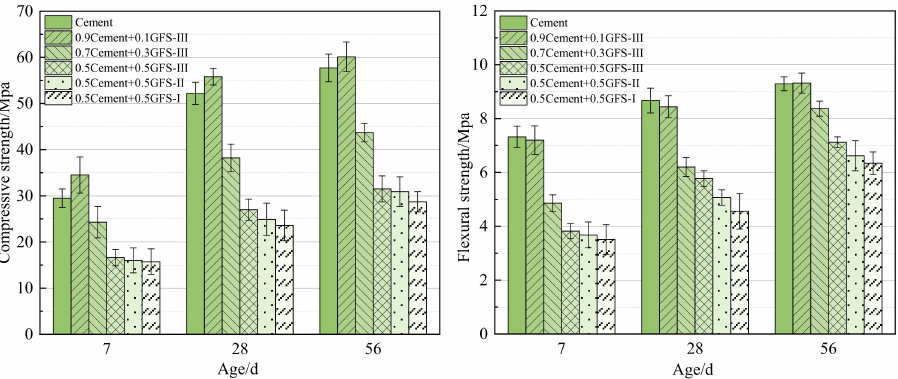
Figure 16. Compressive and flexural strength properties of the cement mortar